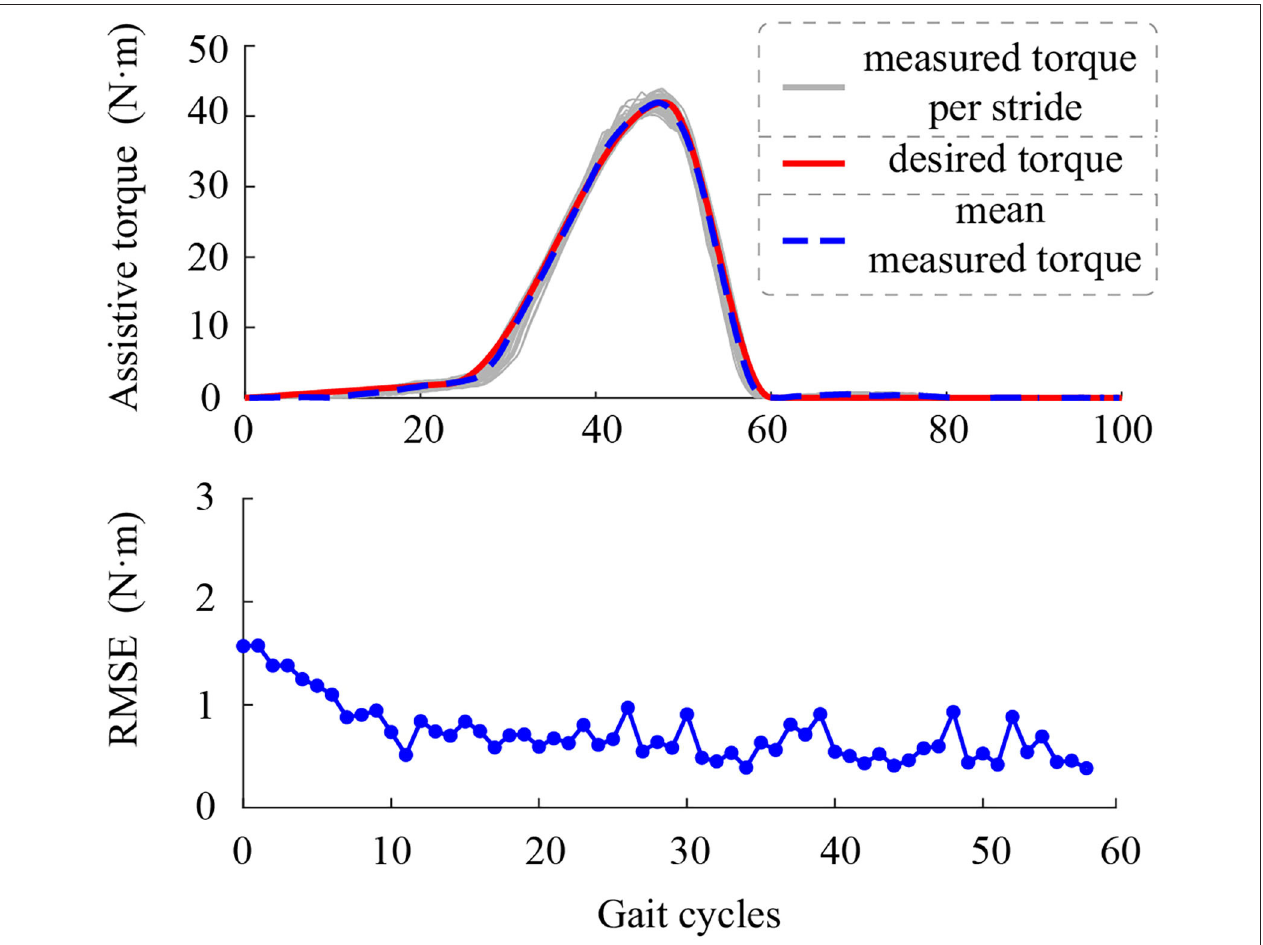
FIGURE 4 | Torque tracking performance and root-mean-square error of each gait of the